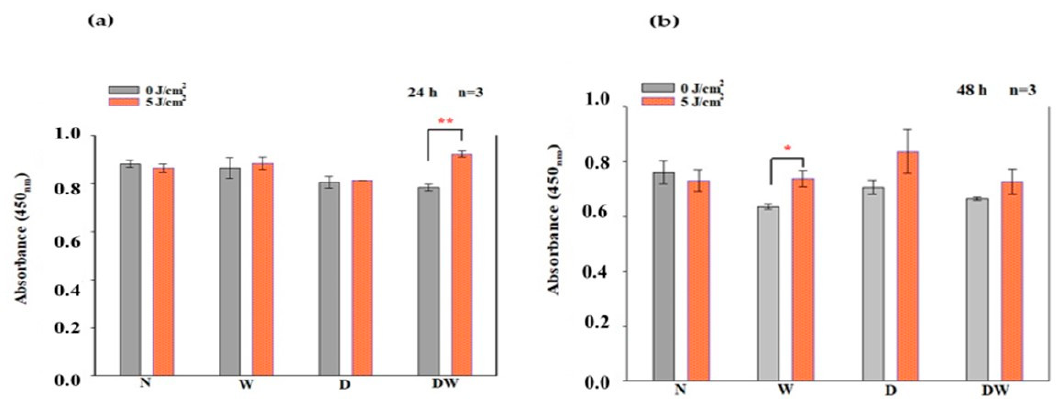
Figure 8. Phosphorylated (p-) MEK1/2 following irradiation at 660 nm and a fluence of 5 J/cm 2 , as determined by ELISA in non-irradiated and irradiated normal (N), wounded (W), diabetic (D), and diabetic wounded (DW) cell models at 24 h ( a ) and 48 h ( b ) post-irradiation. Data are expressed as ± SEM (n = 3). Significant probabilities compared to the non-irradiated controls are shown as * p < 0.05 and ** p < 0.01.